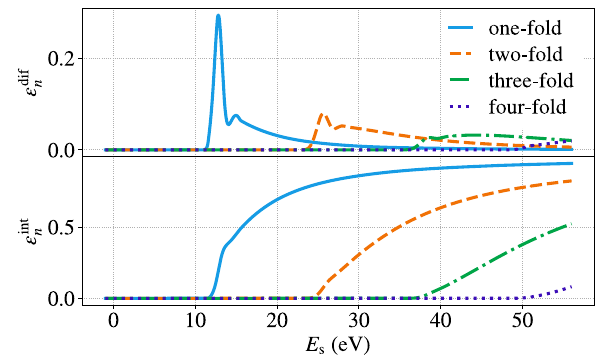
Fig. 8 Simulated background spectra with and without multiplicity ˆ M > 1 cut for the differential mode after applying the TOF selec- tion. The background spectra without multiplicity cut (orange) show the shape of an integral response function (cf. Fig. 3). The TOF selec- tion (not shown) does not affect this shape of background electrons. The backgroundspectraaftermultiplicitycut(blue)arestronglyreducedbut are deformed in shape. The shaded areas show the 1 σ intervals result- ing from the uncertainty on the mean emission multiplicity ˆ S of the ion events provided in Eq. (5)